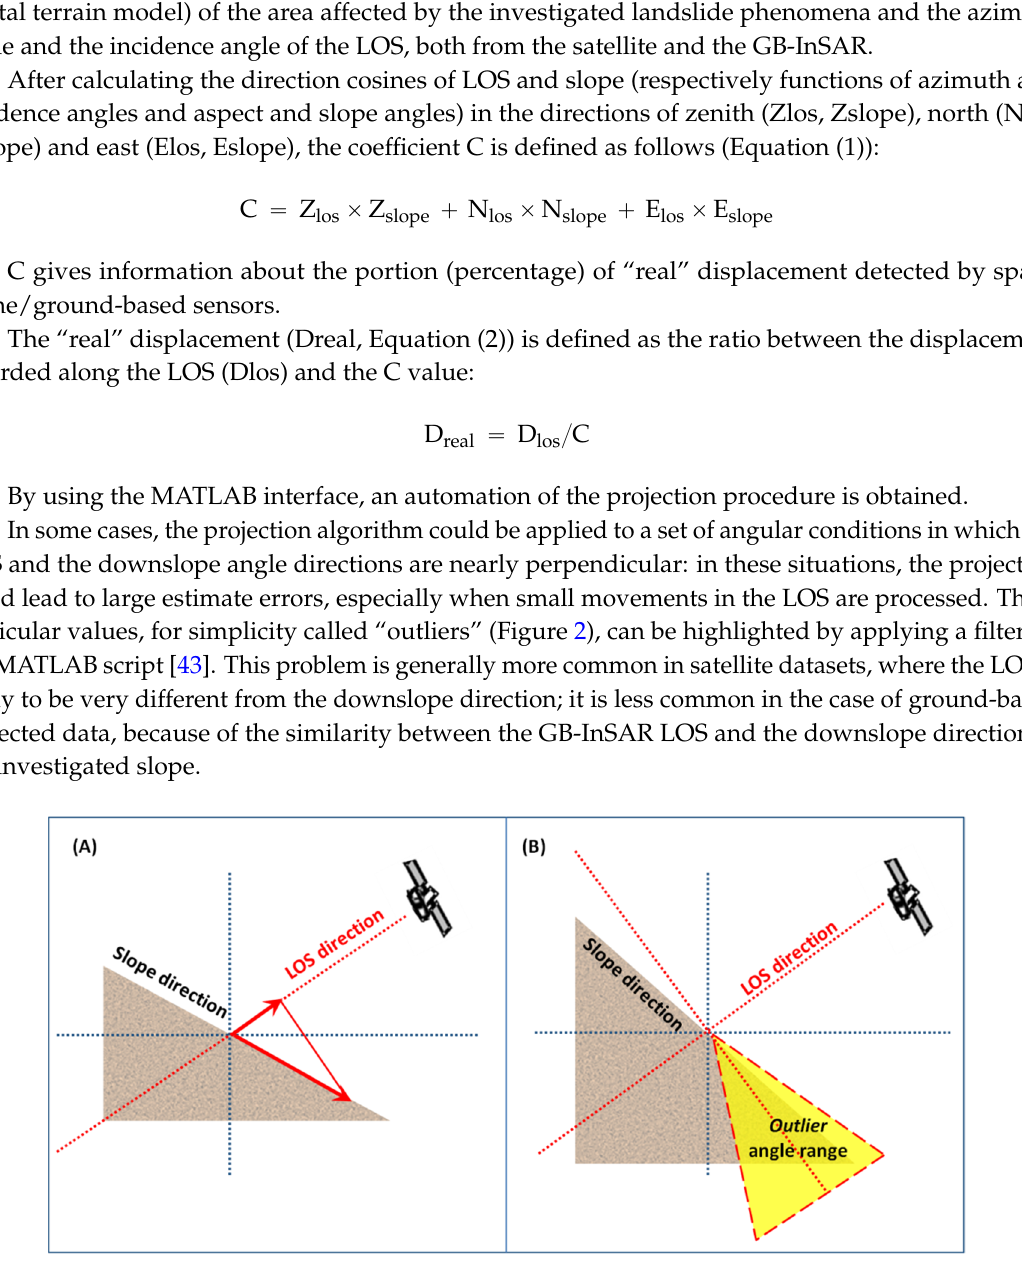
Figure 2. Projection geometry of LOS movement on slope direction ( A ) and the definition of outlier angle range ( B ) (modified from [39]).